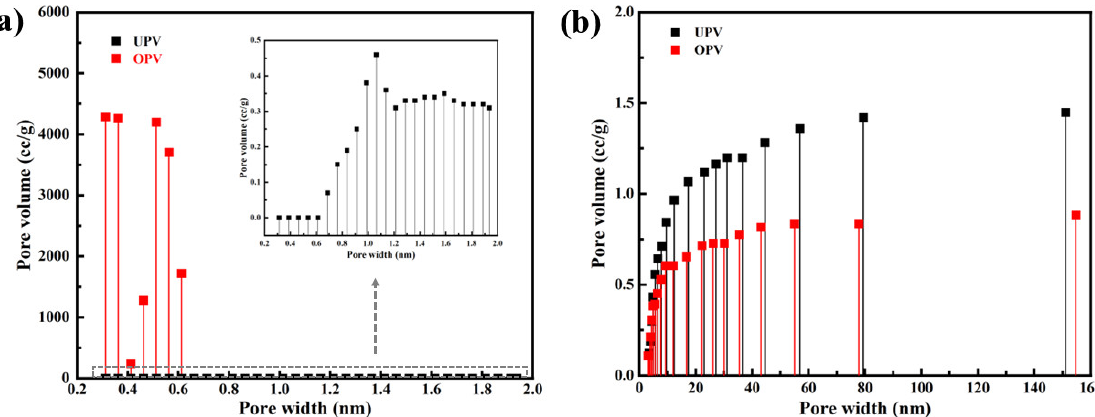
Figure 8. Pore size distribution of UPV and OPV ( a ) micropore; ( b ) mesoporous and megalopore. Table 4. Surface area and pore volume parameters of UPV and OPV.